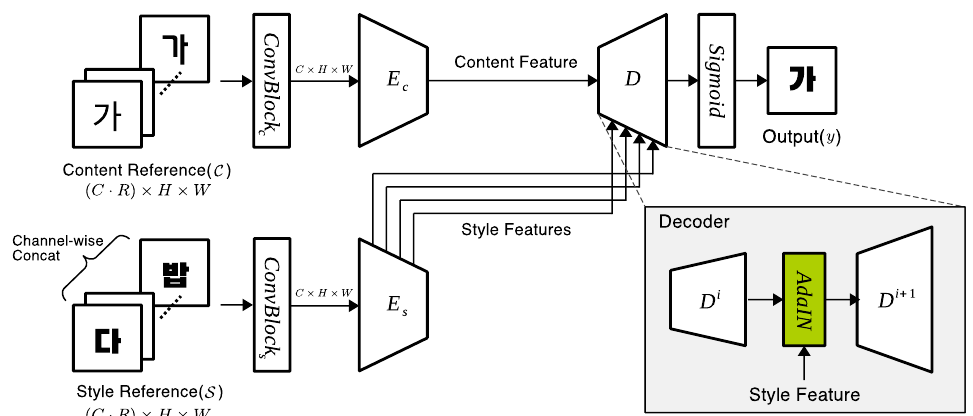
Figure 2. An overview of our proposed method with a few reference images. Images of content reference ( C ) share the same content, but style and images of style reference ( S ) share the same style but